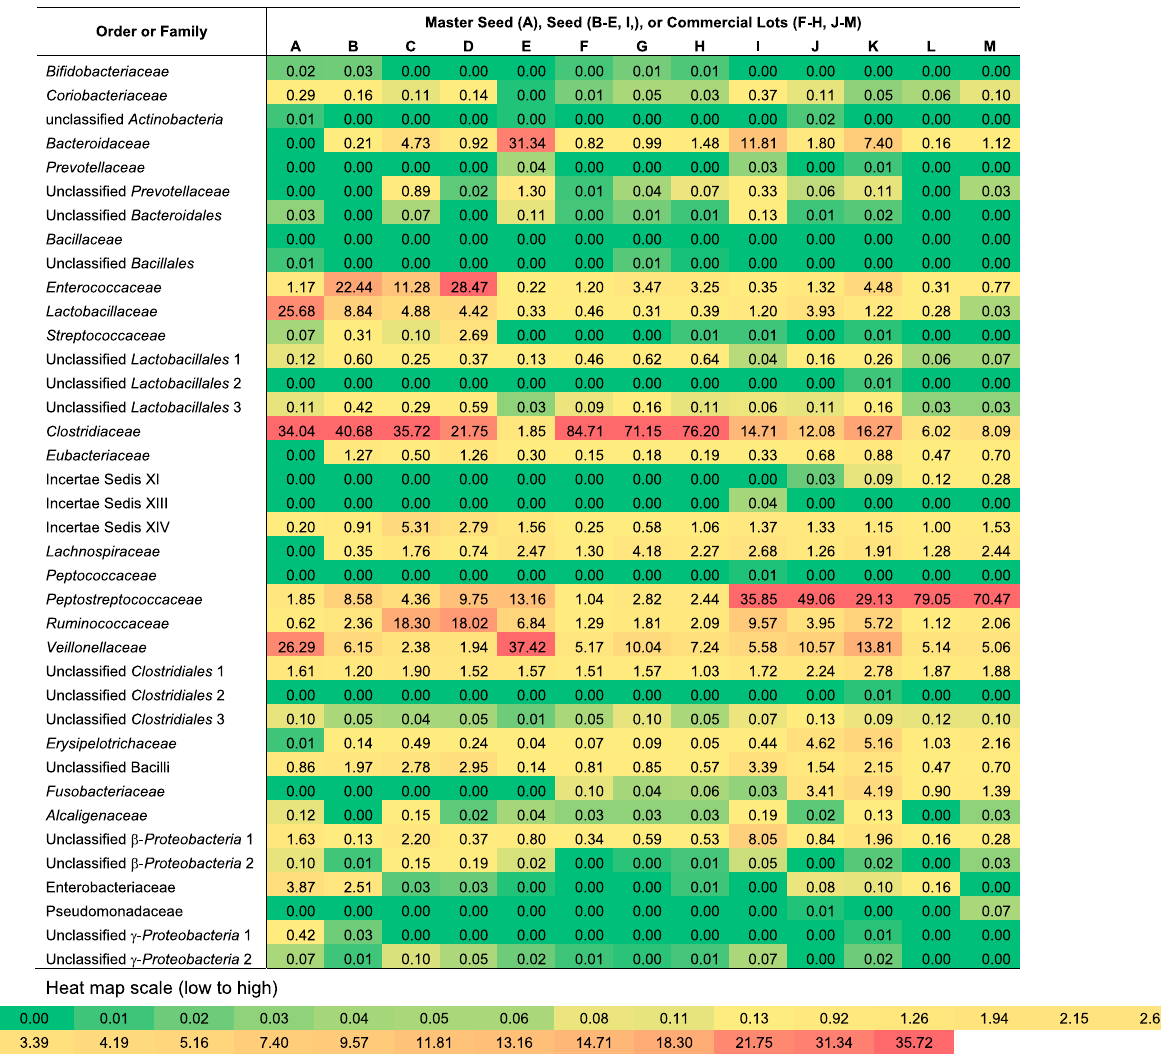
TABLE 1 Proportions of bacterial orders or families detected in competitive exclusion seeds and commercial